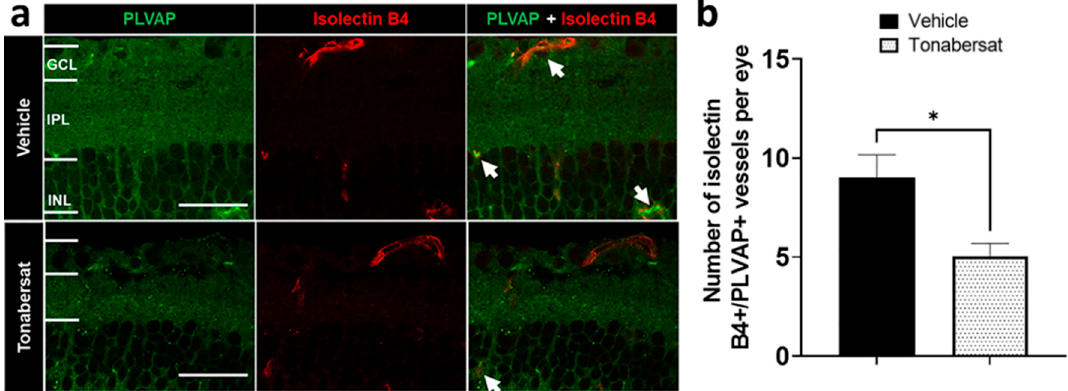
Figure 3. ( a ) Immunohistochemical images showing PLVAP (green) and Isolectin B4 (red) co-labelling in the vehicle and tonabersat groups. The arrows indicate examples of colocalization. GCL = ganglion cell layer; IPL = inner plexiform layer; INL = inner nuclear layer. ( b ) Tonabersat treatment decreased the number of PLVAP+/Isolectin B4+ blood vessels in the retina. Data are presented as a mean + SEM. Statistical analyses were carried out using Student’s t -test. * p ≤ 0.05. Scale bar = 50 µm.